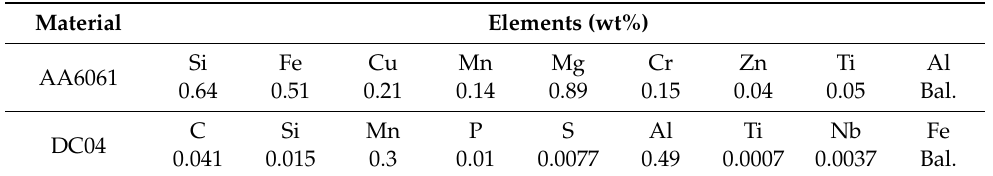
Table 1. Chemical composition of the investigated